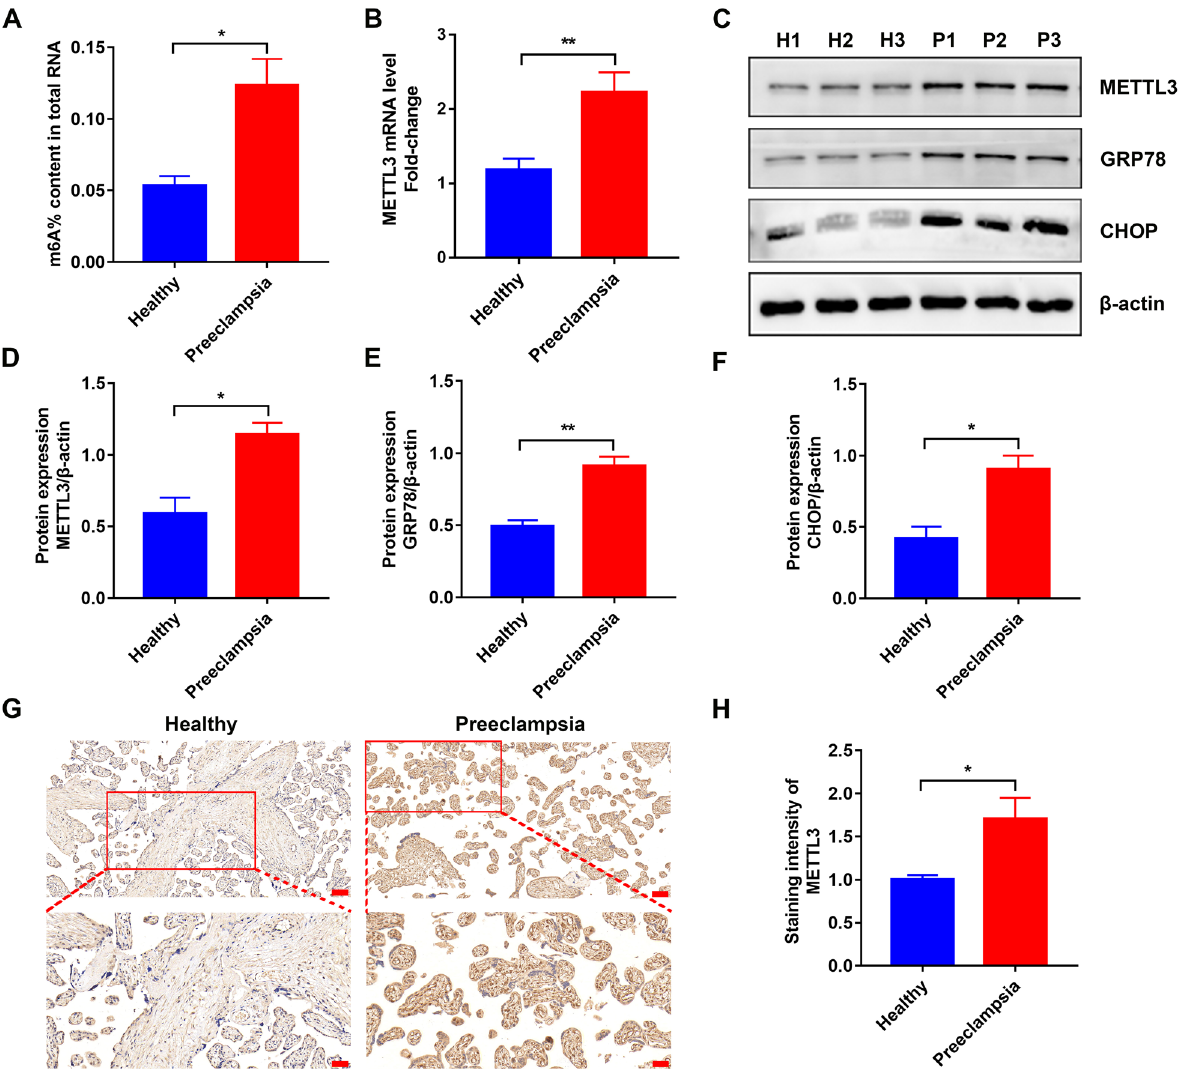
Fig. 1 Different METTL3 expression and m 6 A levels in the placentas from preeclamptic and healthy pregnant women. A The different m 6 A levels determined by m 6 A colorimetric assay. B The different METTL3 mRNA levels detected by qRT-PCR. C – F Representative WB images and densitometry quantification of METTL3, GRP78 and CHOP. The data were normalized to β-actin. G METTL3 expression determined by IHC. Photographs were obtained at 100 (up, Scale bar 100 μm) and 200 (down, Scale bar 50 μm) magnification. H Qualified data shown in G . H Healthy Pregnant × × Women; P: Preeclamptic Pregnant Women. n 3. ns: no significance, *p < 0.05, **p < 0.01, ***p < =